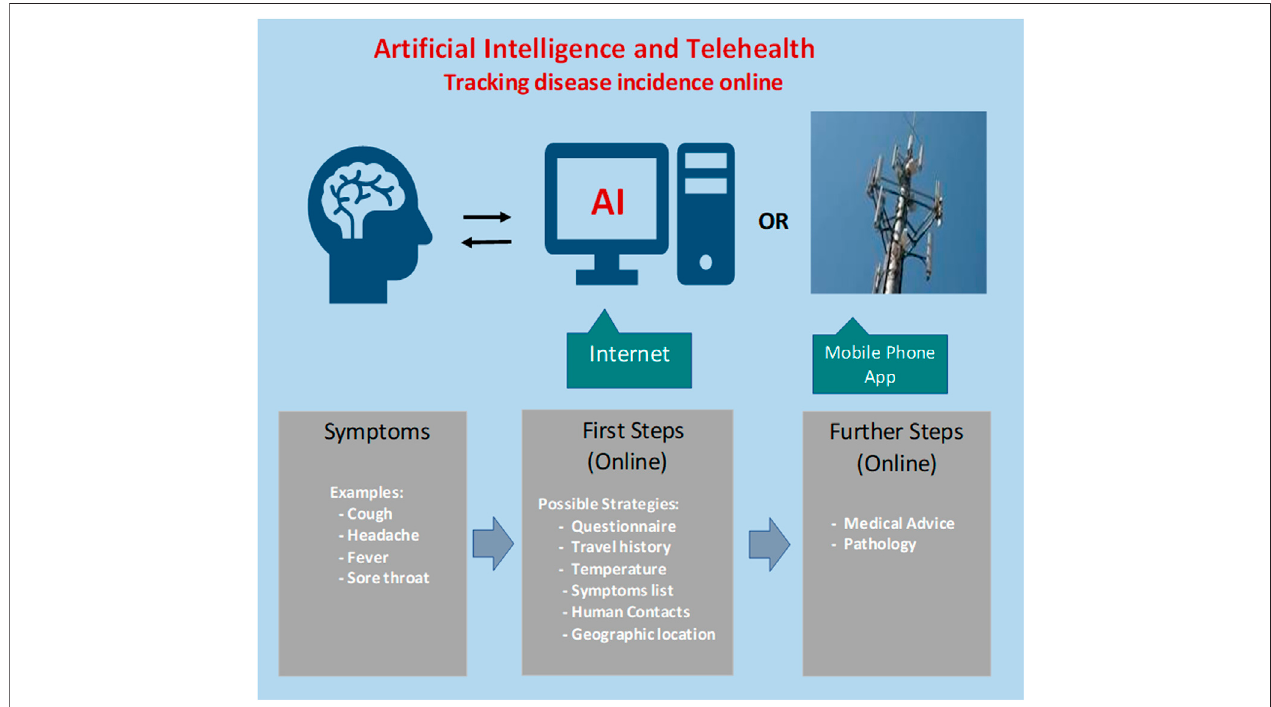
FIGURE 1 | Steps for designing an arti fi cial intelligence-based tracking procedure for regional incidence of COVID-19 virus activity. Concerned citizens with possible symptoms could login and answer a series of questions. Feedback would indicate whether further follow-up is warranted.